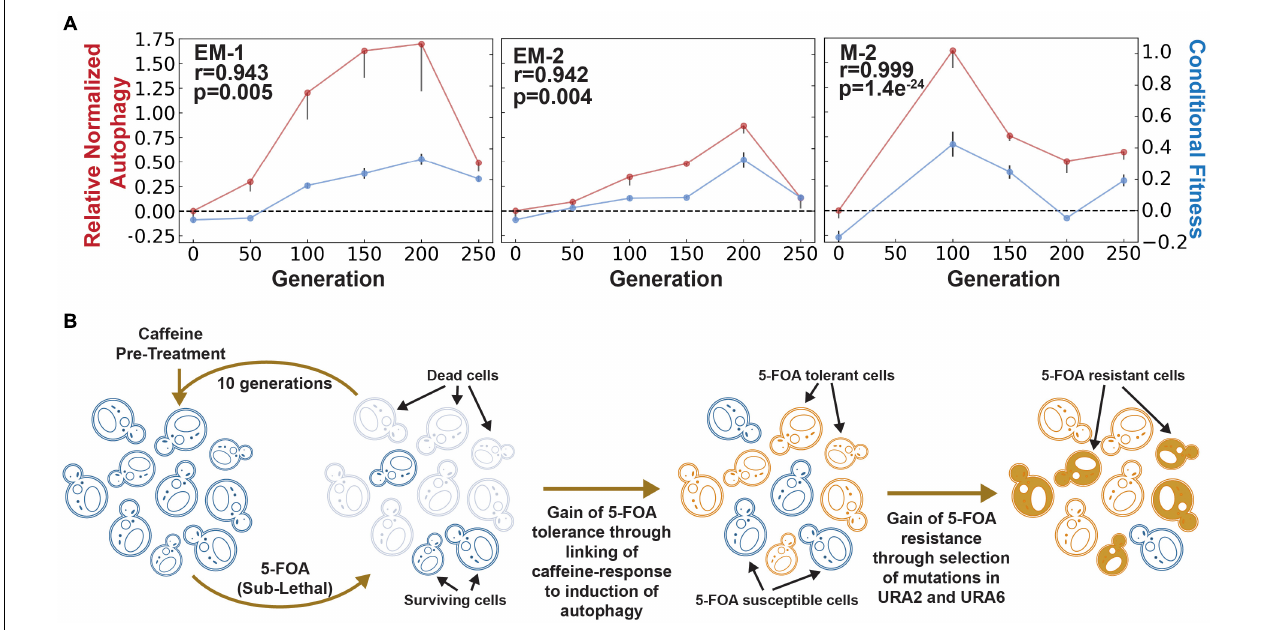
FIGURE 2 | Evaluation of autophagy as a mechanism for adaptive prediction. (A) Relative normalized autophagy and conditional fitness in EM and M cell lines. AP emerged within 100–150 generations in all evolved lines. Spearman correlation (r) between conditional fitness and relative normalized autophagy, and associated significance ( p -value), is indicated for each evolved line. (B) Model for how rewiring of a neutral cue-induced response to autophagy is a generalized mechanism for generating AP-based tolerance and subsequent resistance to a lethal stress. Rise of a tolerant population due to AP could ultimately potentiate development of resistance through subsequent selection of mutations in specific genes and pathways targeted by the lethal stress (in this example, mutations in Ura2/Ura6 genes of uracil biosynthesis pathway for constitutive resistance to 5-FOA).